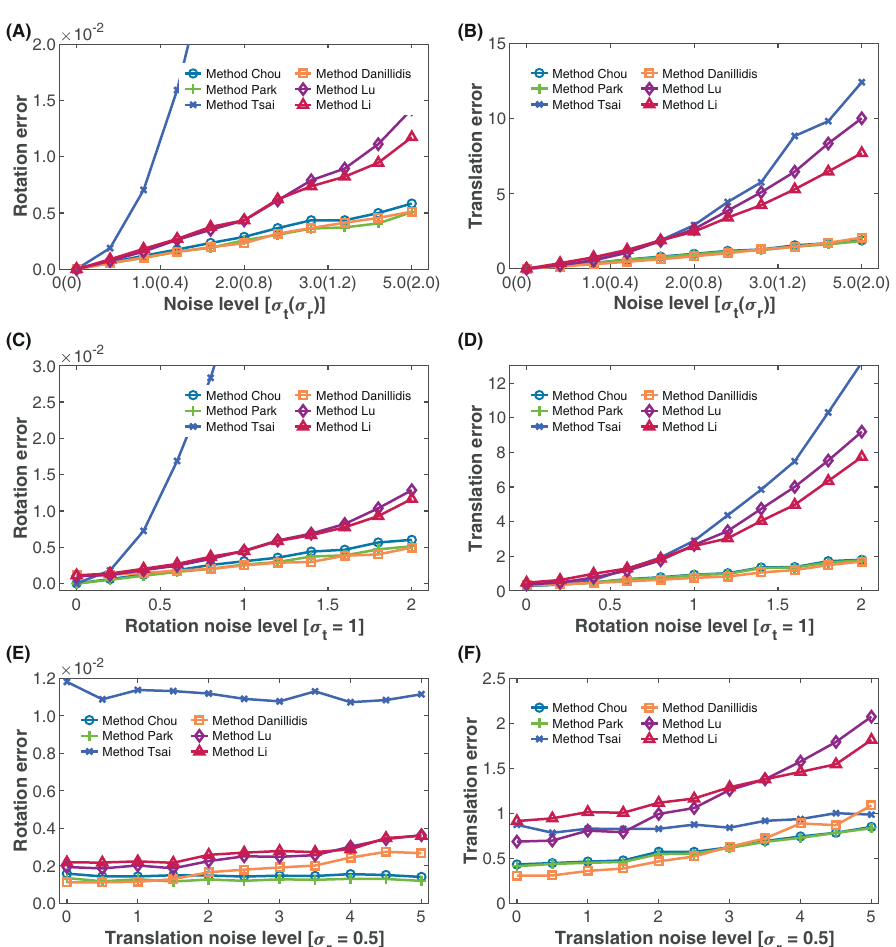
Fig 6. Effect of combined rotation and translation noise on calibration accuracy. (A) Effect of increasing rotation and translation noise on rotation accuracy. (B) Effect of increasing rotation and translation noise on translation accuracy. (C) Effect of rotation noise on rotation accuracy with fixed translation noise σ t . (D) Effect of rotation noise . (E) Effect of translation noise on rotation accuracy with fixed on translation accuracy with fixed translation noise σ t rotation noise σ r (F) Effect of translation noise on translation accuracy with fixed rotation noise σ r